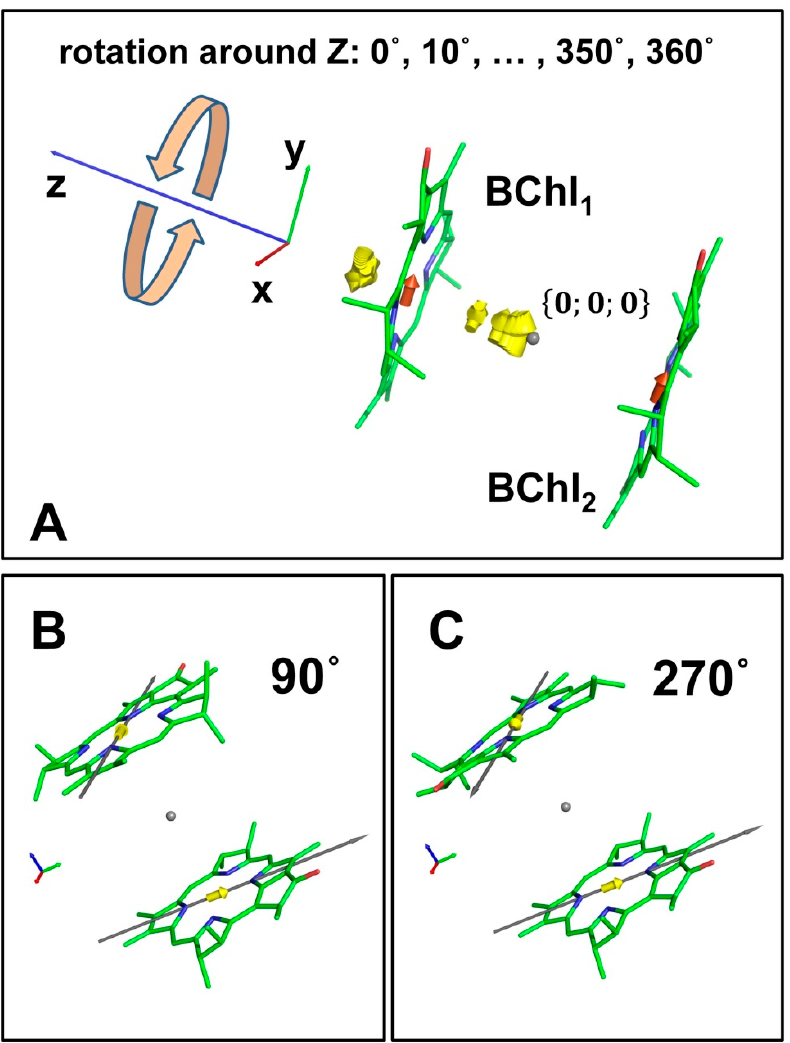
Figure 2. BChl molecule dimer transition moments in the exciton representation (yellow arrows) are shown in one plot ( A ) for each angle of BChl 2 rotating around the z-axis. Red arrows are the Q y transition moments of BChl 1 and BChl 2 in the coordinate representation. Two positions of BChl molecules at which the coupling energy is equal to zero are presented in separate plots ( B , C ). Gray points are the origin of coordinates.